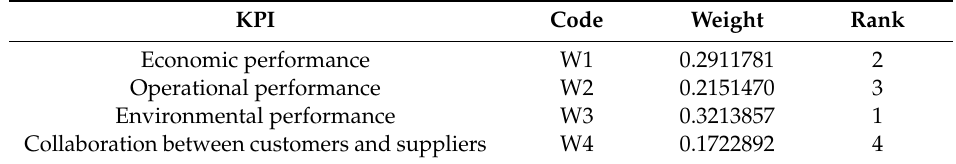
Table 16. Weight and ranking of KPIs in strategic indicators category (taken from fuzzy nonlinear